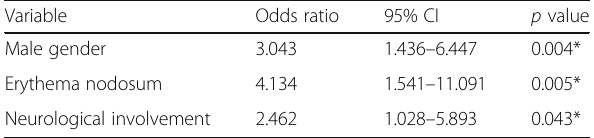
Table 4 Predictive factors independently associated with cardiovascular involvement in patients with BD in multivariate